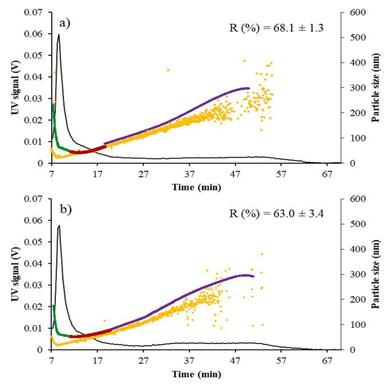
MD-AF4 fractograms of liposomes (a) and loaded liposomes with quercetin (b). Black line: UV–Vis linear response at 250 nm; yellow dots: hydrodynamic diameter obtained by DLS in flow mode; green and red dots: geometric diameter of the first two size populations detected by MALS and elaborated by the Zimm model; violet dots: geometric diameter of the third size population detected by MALS and calculated by the Sphere model. The maximum recovery for both loaded and unloaded liposomes is reported in the insight